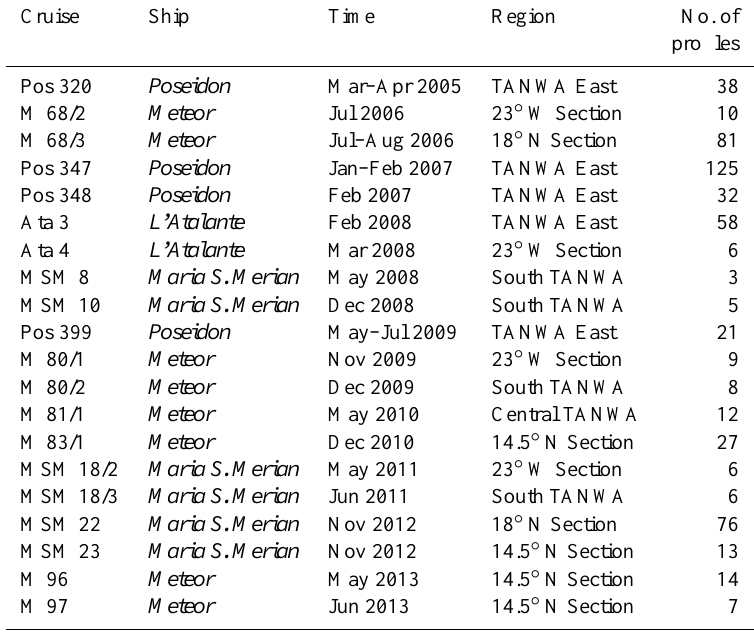
Table 1. Data from the following research cruises were used. Cruise